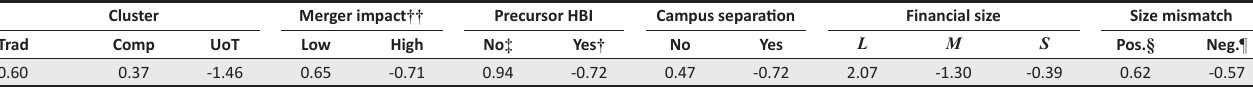
TABLE 9: Average financial health score by characteristic. Cluster Merger impact